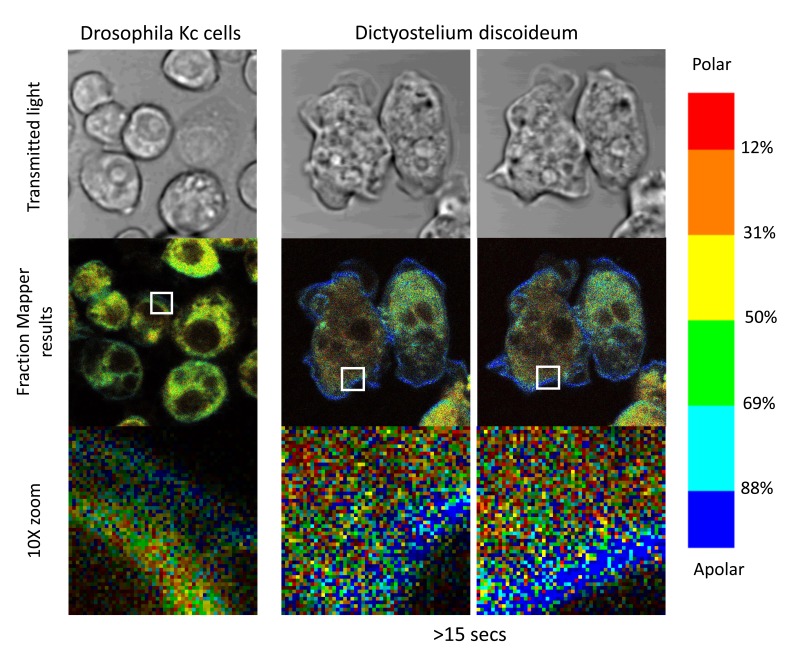
Staining of
Drosophila and
Dictyostelium cells.Right column: KC cells from Drosophila melanogaster were grown for 48 hours on PLL-coated coverslips in a 6-well plate before transfer to an observation chamber and staining with 400 nM of C-laurdan in serum-free medium. Middle and right columns: Dictyostelium discoideum amoebae (AX2 strain) were transferred directly to an observation chamber with a glass coverslip bottom for a couple of hours in axenic medium before staining with 800 nM C-laurdan in Sörensen’s buffer. The pictures in the right column, taken 15 seconds after those in the middle column, show that the motility of the amoebae triggered by the stimulation by light of these photo-reactive cells is not accompanied by any noticeable modification in the overall state of their lipid membranes. All pictures were taken at zoom 6: whole picture 35×35 µM, pixel size : 69 nm Droso: Tests 20 Oct 2016 Droso KC (Z6 3) Dictyo :Tests 25 Oct 2016 : AX2 Z6.